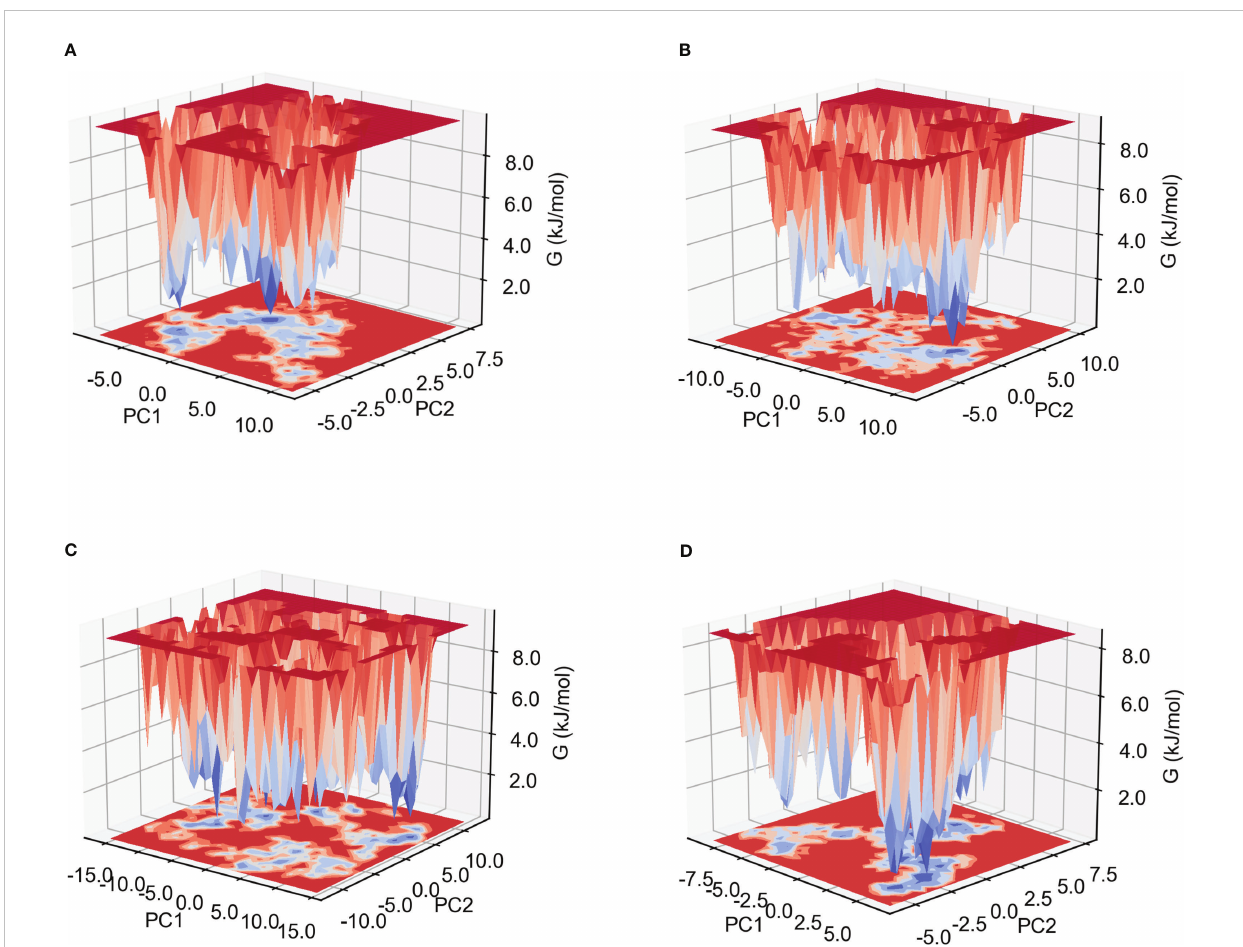
reactions, these elevations were elevated to a greater degree, and the elevation of different immunoglobulins and the immunocomplexes (IgM+IgG, IgG1+IgG2, IgG1, memory B cells and plasma cells (isotype: lgG1, lgG2) were also observed (Figures 9B, C; Supplementary Figure 9B, C). As shown in